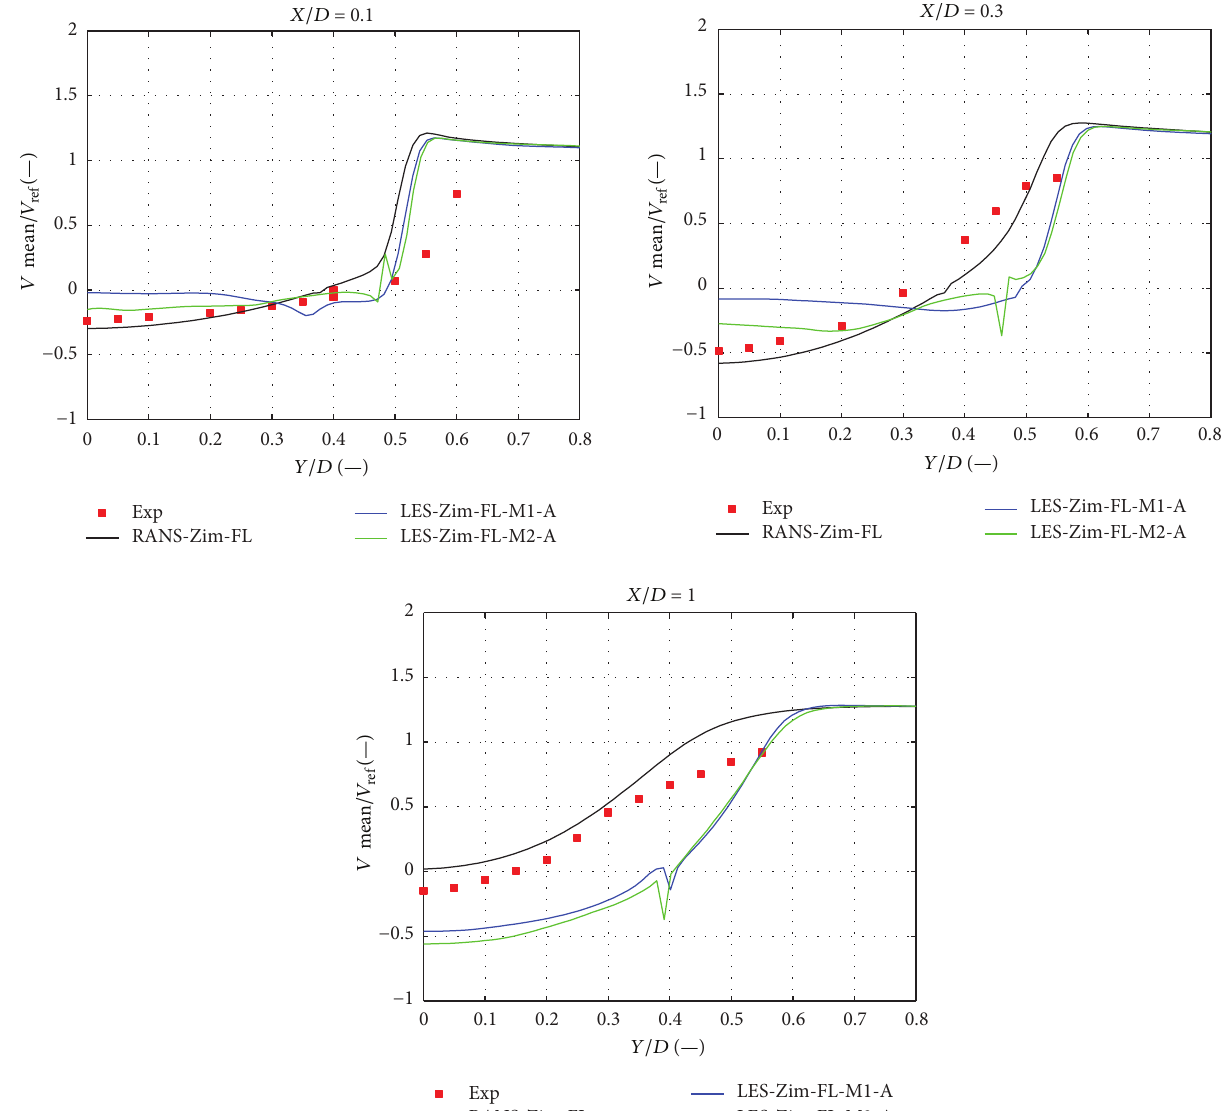
Figure 11: Mean axial velocity profiles at different axial